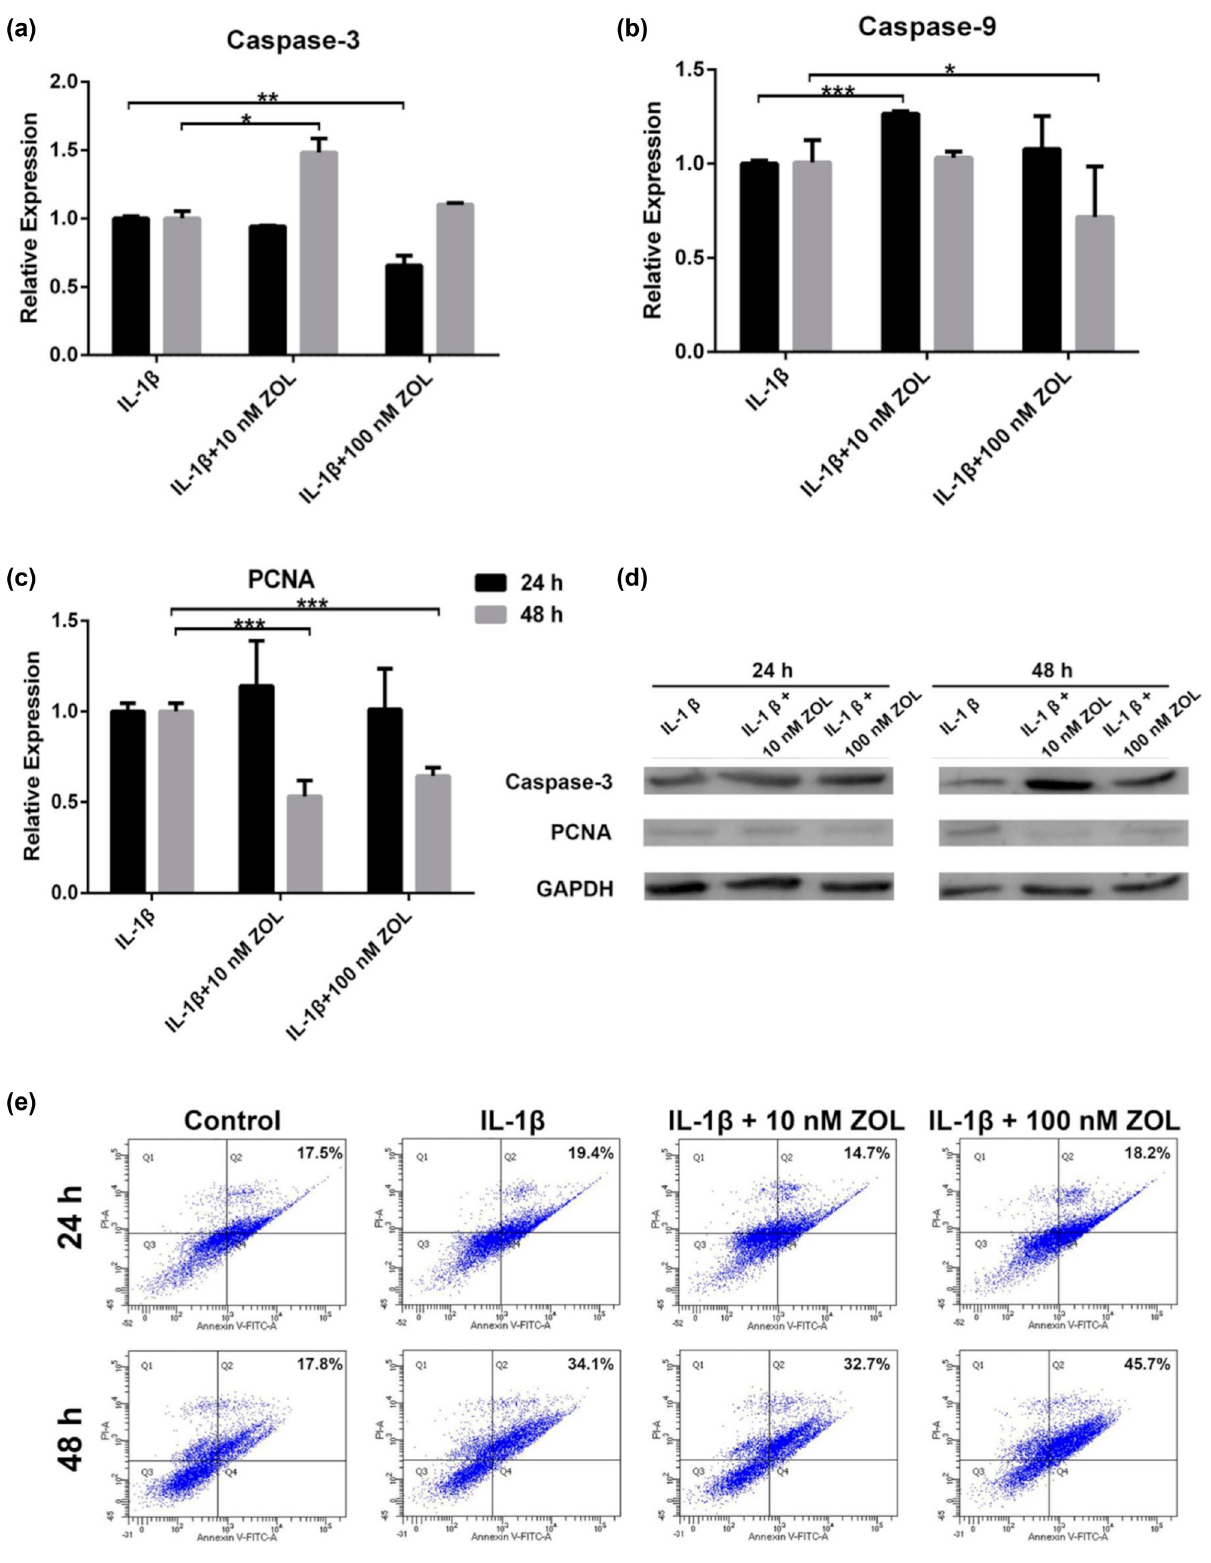
Figure 4: Expression levels of apoptosis - and proliferation - related genes, proteins, and percentage of apoptotic cells after treatment with 10 or 100 nM ZOL in IMCCs. ( a ) Caspase - 3, ( b ) Caspase - 9, and ( c ) PCNA were analyzed by qRT - PCR. ( d ) Caspase - 3 and PCNA proteins were detected by western blotting. ( e ) Flow cytometry analysis for the apoptotic cells. All data are presented as mean ± SEM. * p < 0.05, ** p < 0.01, *** p < 0.001 between the two groups linked by the line; all other comparisons are not signi fi